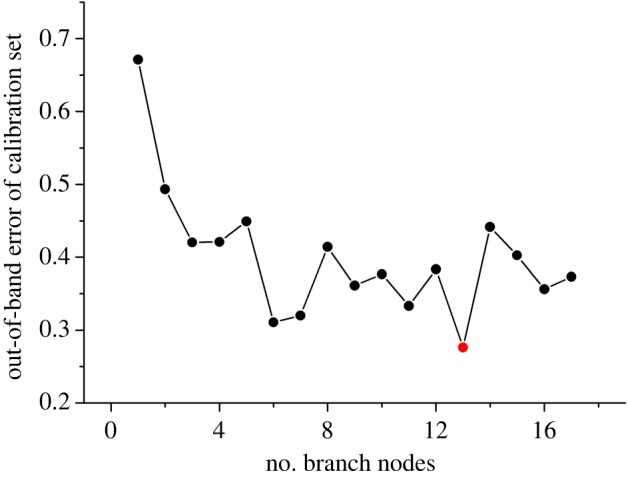
The selection results of mtry using the mid-level fusion strategy.